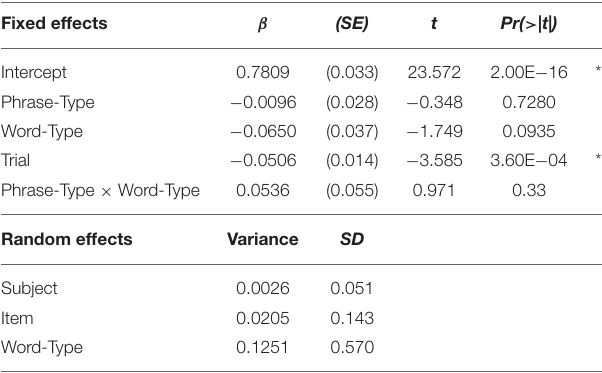
TABLE 6 | L1 form accuracy LMER